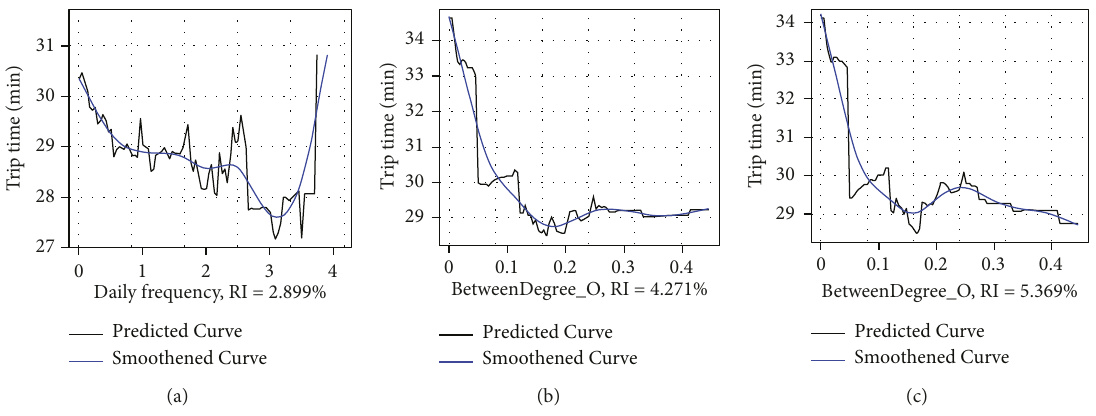
Figure 5: The effects of daily travel frequency and betweenness degree on trip time.